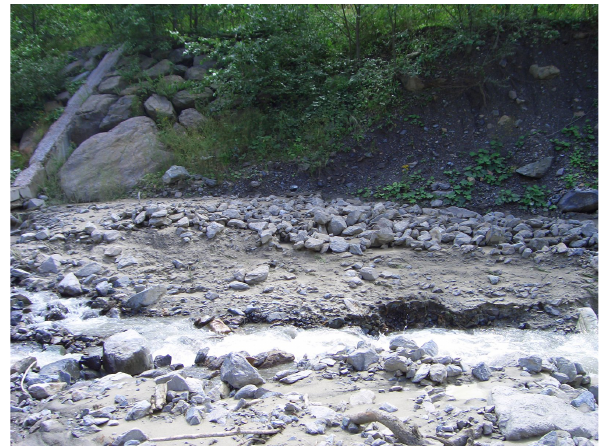
Fig. 6. Deposits of the 24 August 2006 event in the mid-fan area: the low thickness of the deposits and the absence of large clasts are consistent with the small magnitude of the event.